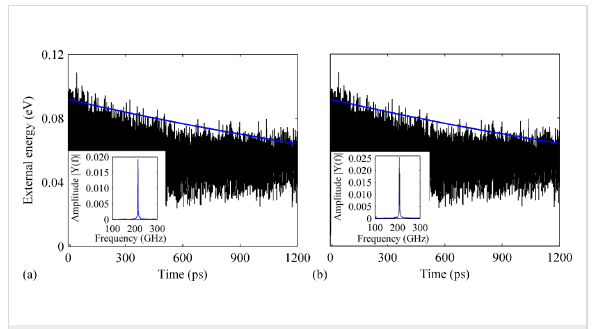
Figure 3: Variation of history of the external energy over time for a perfect GNR with B-dopant densities of (a) 0.76% and (b) 1.89%. The insets show the corresponding frequency spectra.